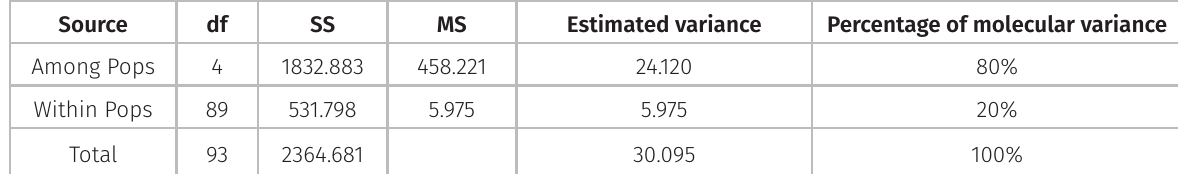
Table VI. Analysis of molecular variance (AMOVA) in segregating populations of Psidium spp. by simple sequence repeat (SSR)